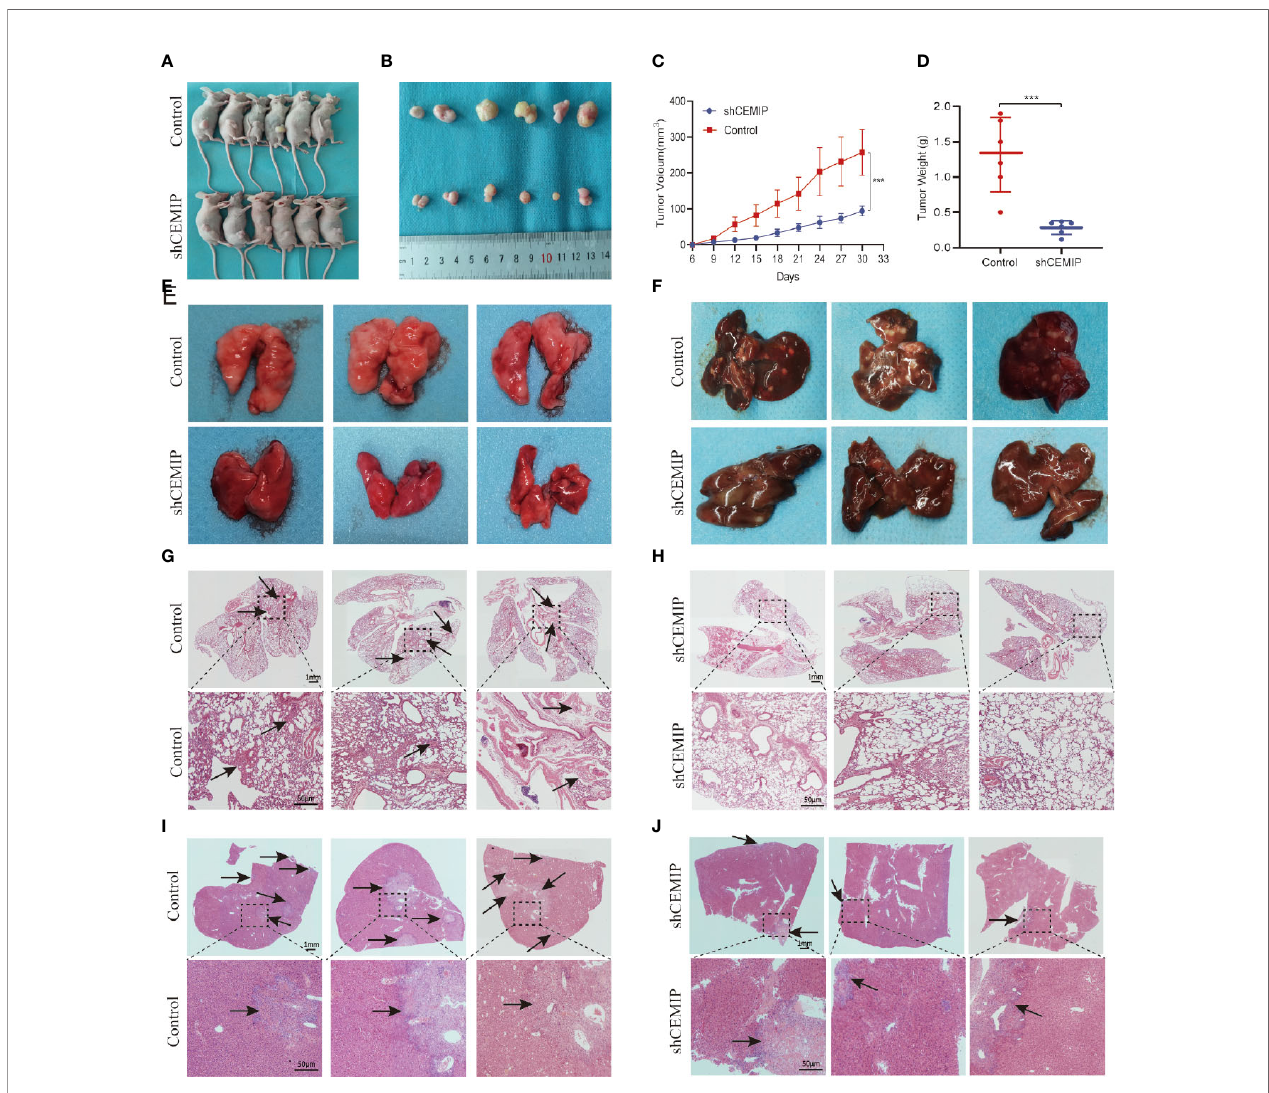
FIGURE 5 | CEMIP promotes the growth and metastasis of osteosarcoma in vivo. (A) Representative images of xenograft models. (B) Representative images of xenograft tumors from respective groups. (C) Tumor growth curves from respective groups. (D) Average tumors weight from respective groups. (E) Representative images of the lungs of nude mice from metastsis models. (F) Representative images of the livers of nude mice from metastsis models. (G, H) Histological features of lung metastases by H&E staining. (I, J) Histological features of liver metastases by H&E staining. ***P <